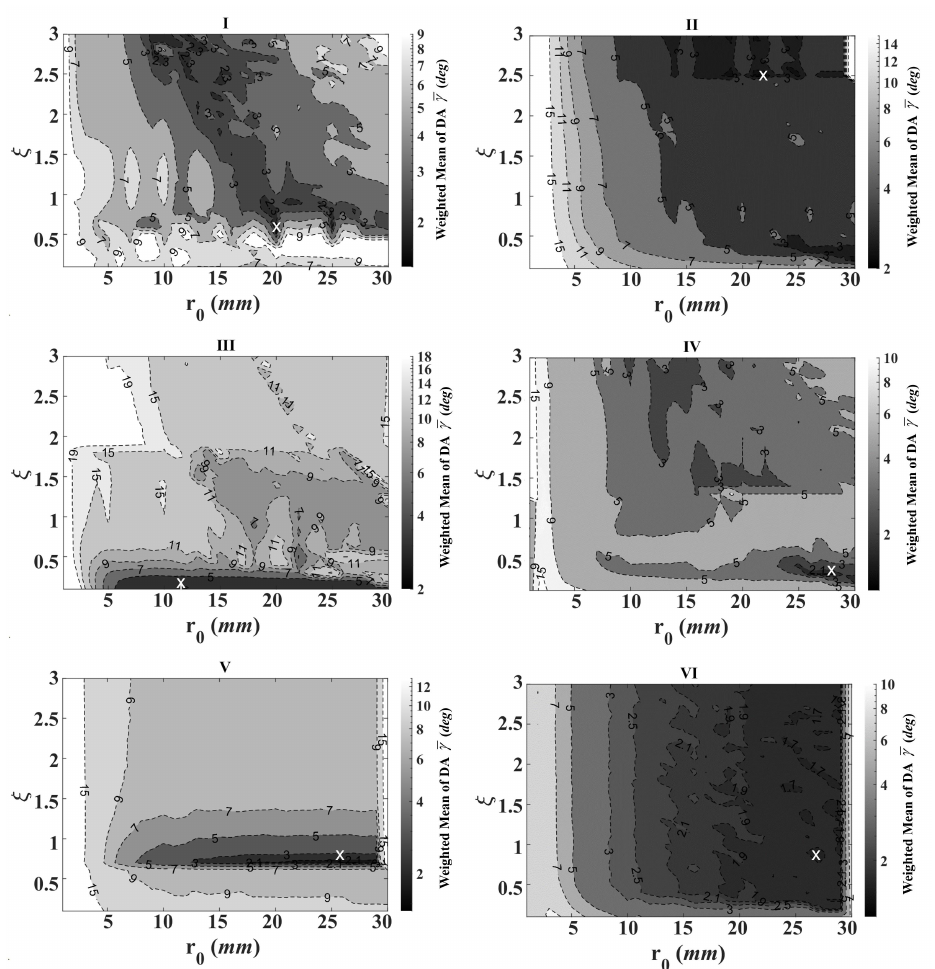
Figure 4. Contour maps of the weighted mean divergence angle, γ , as a function of the two collimating lens parameters, r 0 and ξ , for the six UV-LEDs ( I – VI